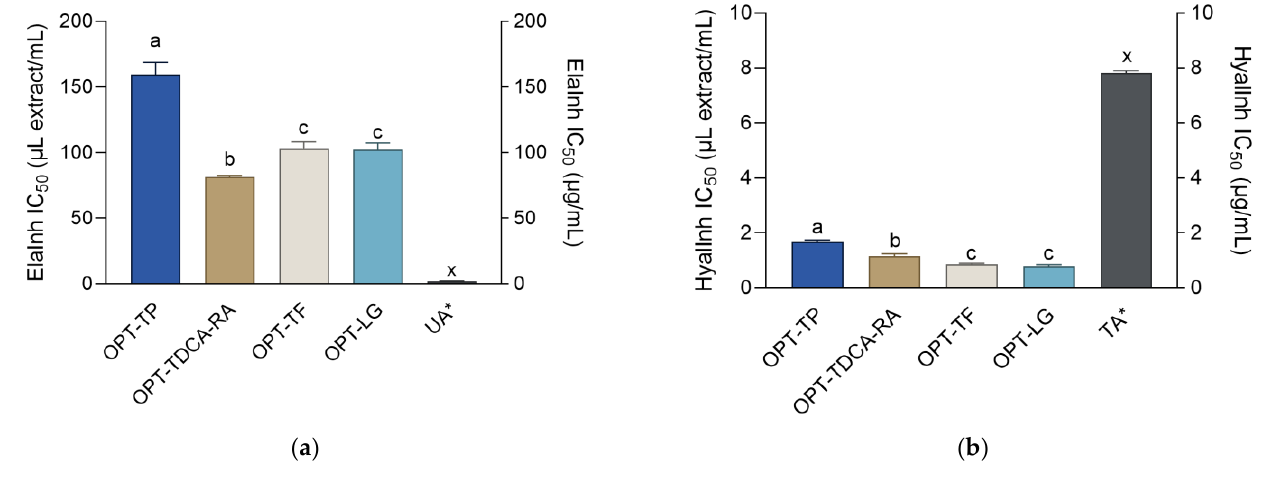
Figure 3. Inhibitory activity of the extracts and corresponding positive controls: ursolic acid (UA) and tannic acid (TA) on ( a ) elastase and ( b ) hyaluronidase. The activities are shown as IC 50 values ± SD. a,c = differences between the extracts within a column (ANO VA followed by Tukey’s post-test, p < 0.05). x = differences with the positive control (ANOVA followed by Dunnett’s post-test, p < 0.05). Columns not connected with the same letter are statistically different. Asterisk indicates that the unit is placed at the right ordinate.